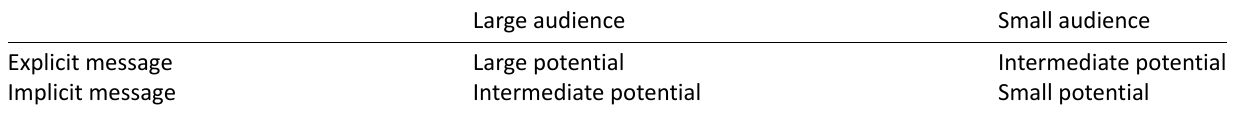
Table 1. Artworks’ potential to contribute to an inclusive public sphere.